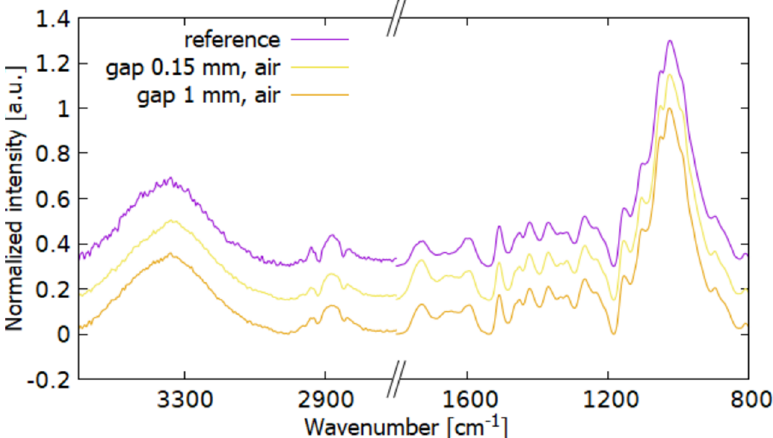
Figure 7. FTIR spectra of wood T200 to compare the change in chemical composition at different distances from the electrode. The treatment was done in the air.